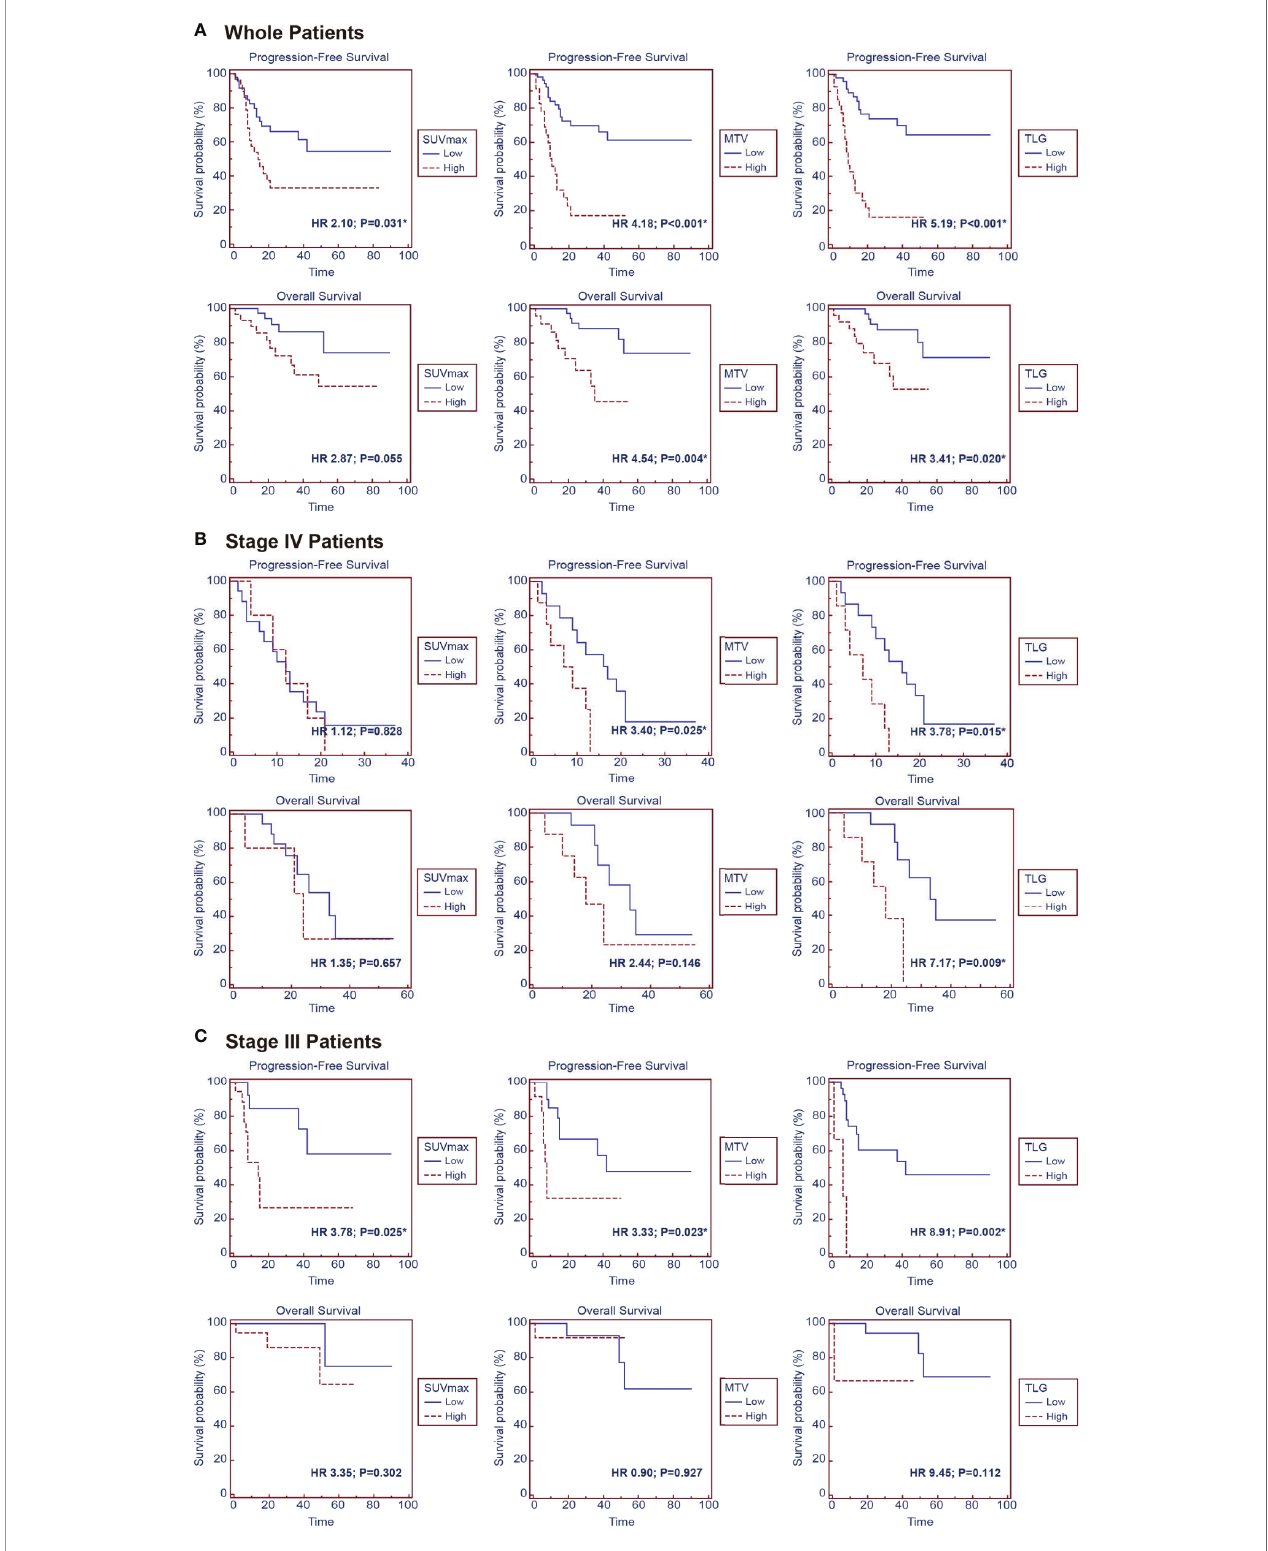
FIGURE 3 | Kaplan – Meier survival curves for progression-free survival and overall survival according to SUVmax, MTV, and TLG in the groups of (A) whole patients, (B) stage IV patients and (C) stage III